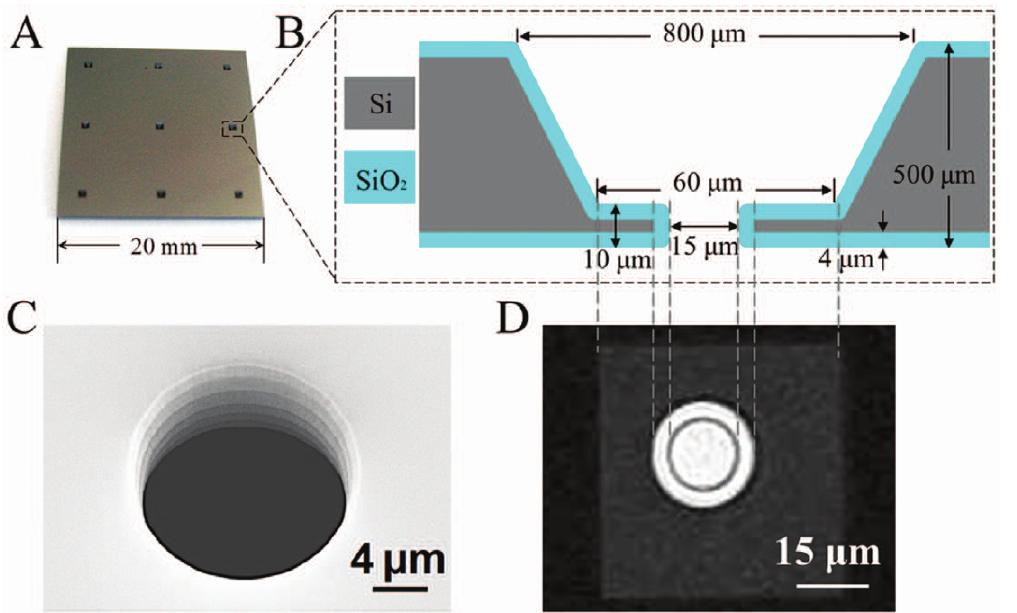
Figure 1. Silicon micropore chip. A. A photograph of the silicon micropore chip. B. Cross-section diagram of the pyramidal opening and the micropore in the silicon chip. A thermally grown silica layer covers the entire chip surface and the pore wall. C. Scanning electron microscopy image